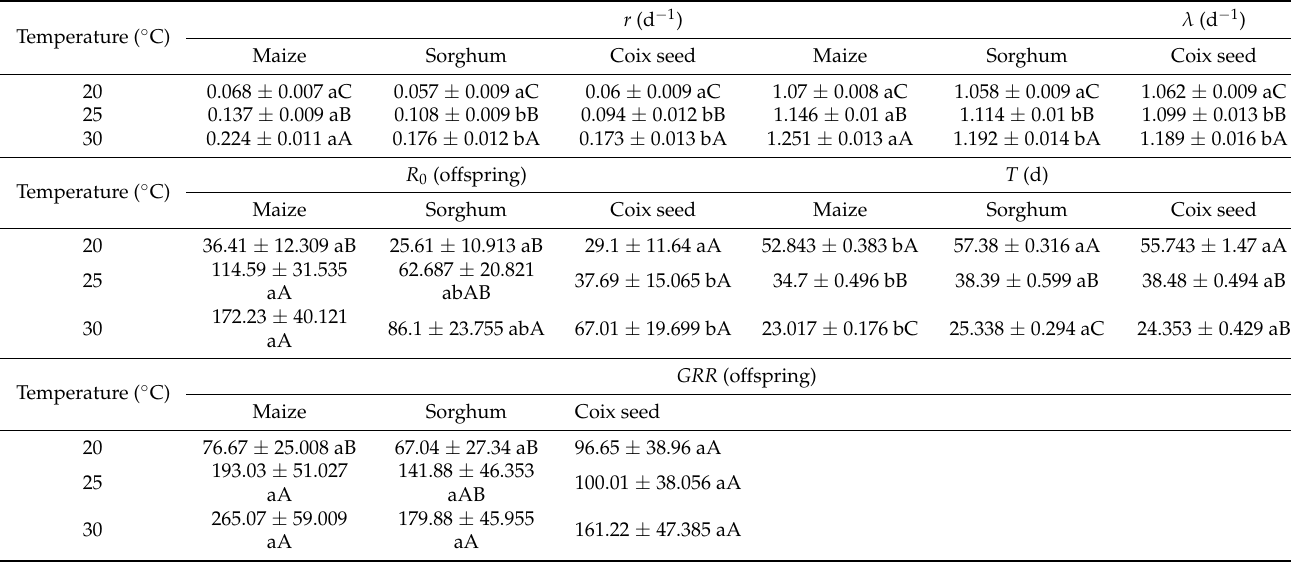
Table 4. The intrinsic rate of increase ( r ), finite rate of increase ( λ ), net reproductive rate ( R 0 ), mean generation time ( T ), and gross reproductive rate ( GRR ) ( ± SE) of Spodoptera frugiperda reared on different host plants at different